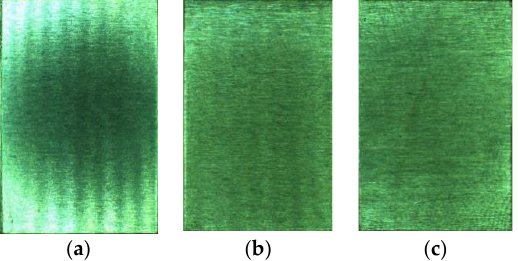
Figure 3. White ring light source.